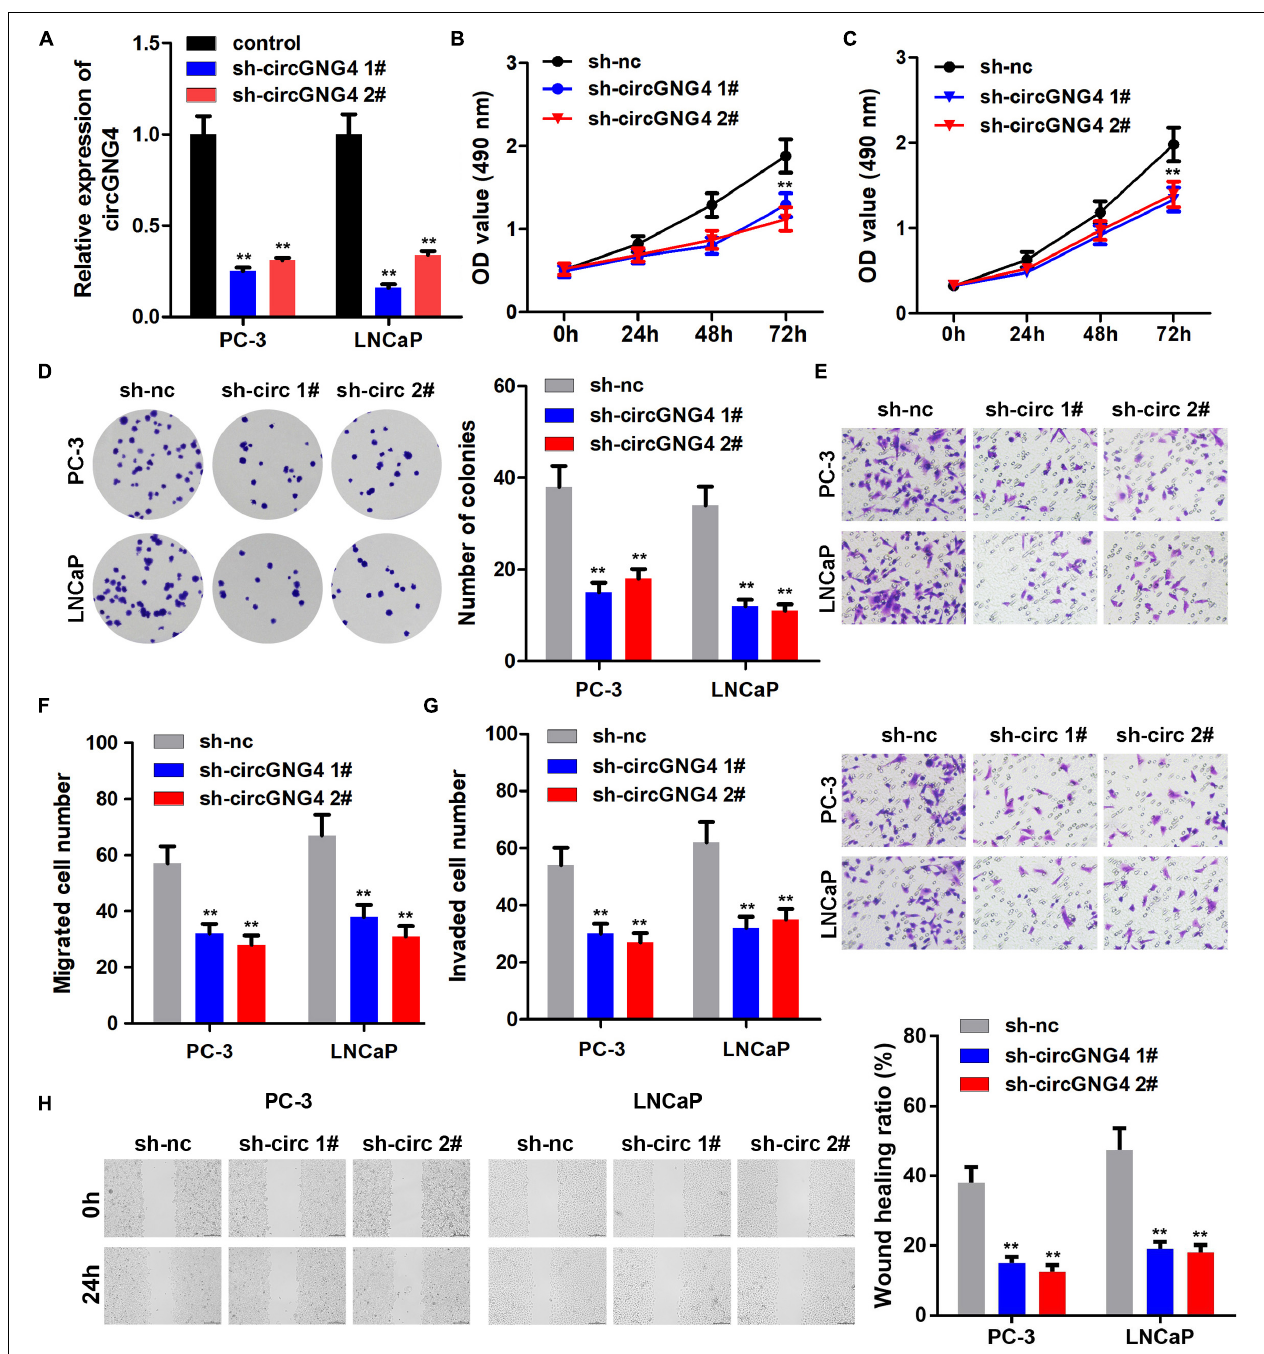
FIGURE 2 | CircGNG4 promoted the progression of prostate cancer in vitro . (A) circGNG4 expression level was detected and the results showed that plasmid knockout could significantly reduce circGNG4 expression. (B,C) Detection of cell proliferation after circGNG4 knockout was determined using a Cell Counting Kit-8 assay. (D) Experimental detection of cell clone formation after circGNG4 knockout. (E–G) Cell migration and invasion were investigated using Transwell assays. (H) Cell migration was investigated using a wound healing assay. ** p < 0.01 vs. sh-NC group. circRNA/circ, circular RNA; GNG4, G protein subunit γ 4; sh, short hairpin RNA; NC, negative